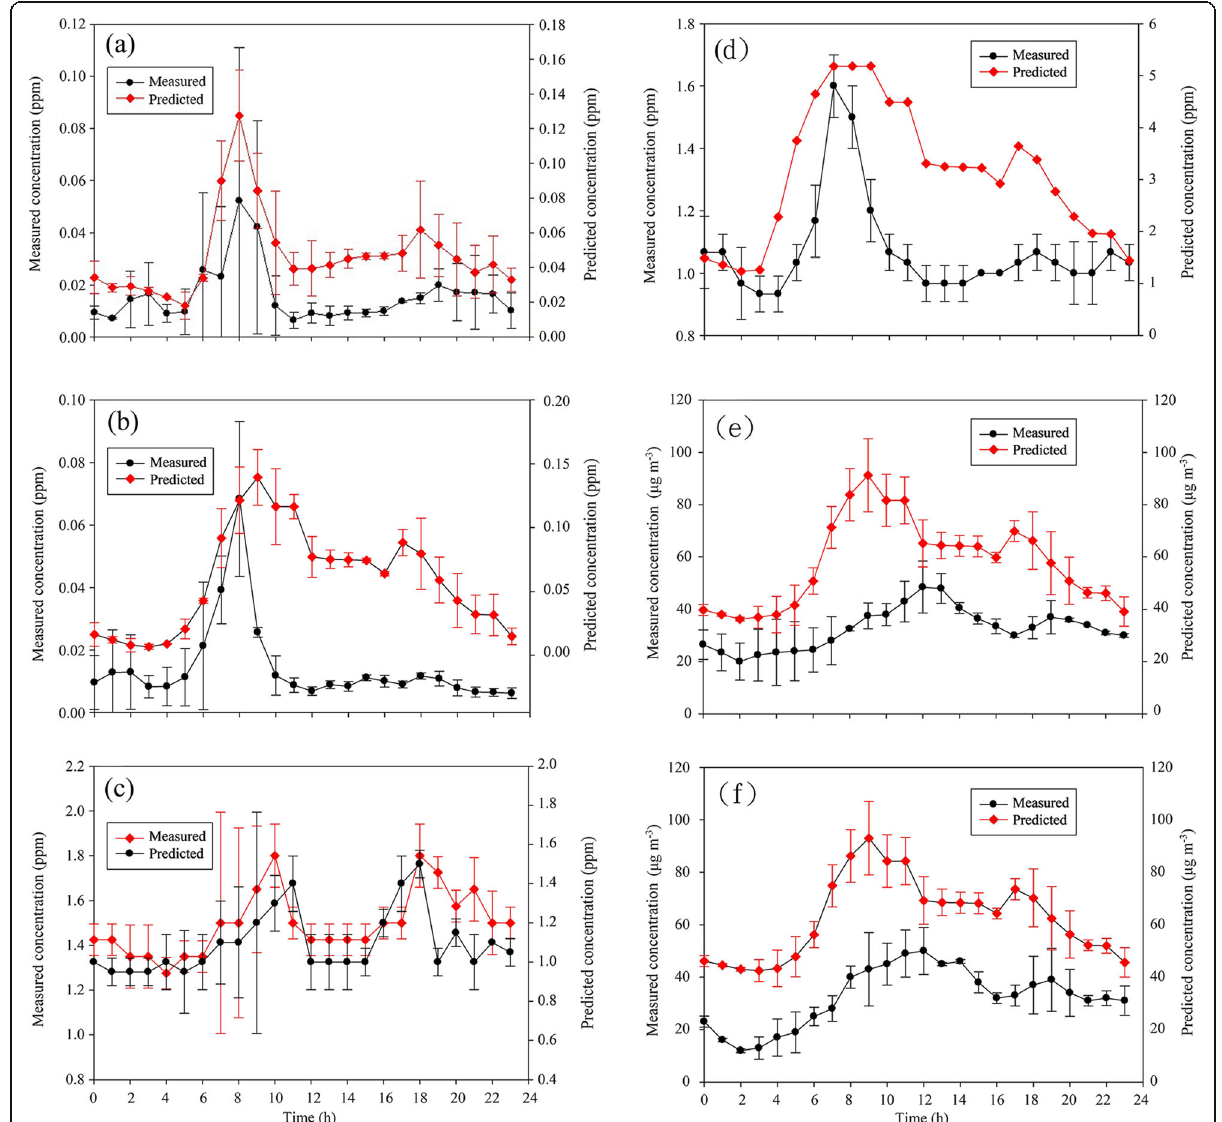
Fig. 13 Comparison of measured and predicted data: a NO on weekdays; b NO on weekends; c CO on weekdays; d CO on weekends; e PM 2.5 on weekdays; f PM 2.5 on weekends